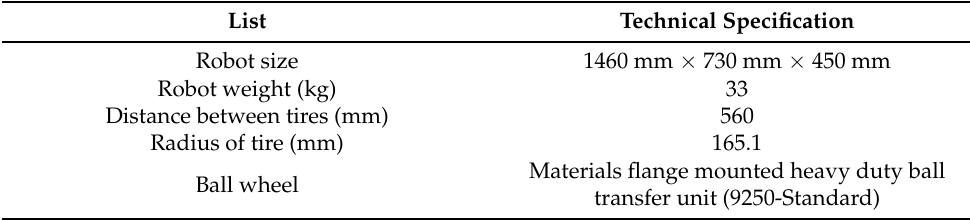
Table 3. Hardware specifications of the robot.